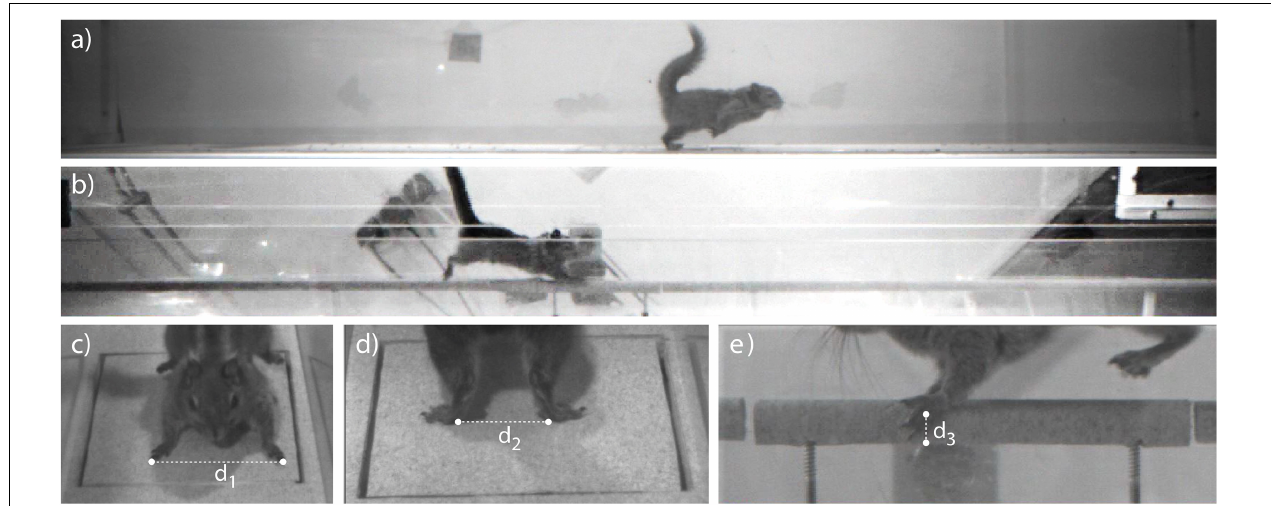
FIGURE 1 | Camera views used for kinematic analysis of the experimental setups. Overview on (A) the flat trackway (here oriented horizontally) and (B) on the branch-like pole (here inclined by 45 ◦ , the squirrel is heading downwards). (C,D) Close-up views on the trackway to measure the distance (d1) between the claws of the phalanges III of the hands and the distance (d2) between the metatarsophalangeal joints III, respectively. (E) Close-up view on the pole to measure the distance (d3) between the metacarpo- and metatarsophalangeal joint III, respectively, and the lower margin of the